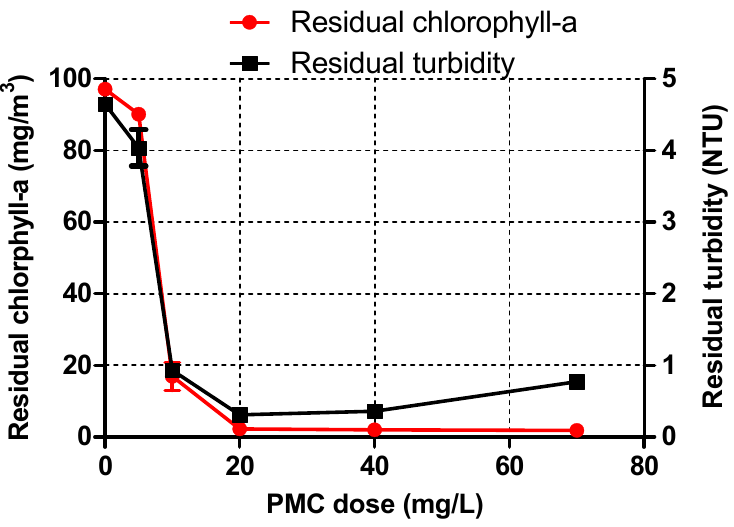
Figure 2. Concentration of chlorophyll-a and residual turbidity after removal with varying doses of the PMC-based coagulant (0, 5, 10, 20, 40, and 70